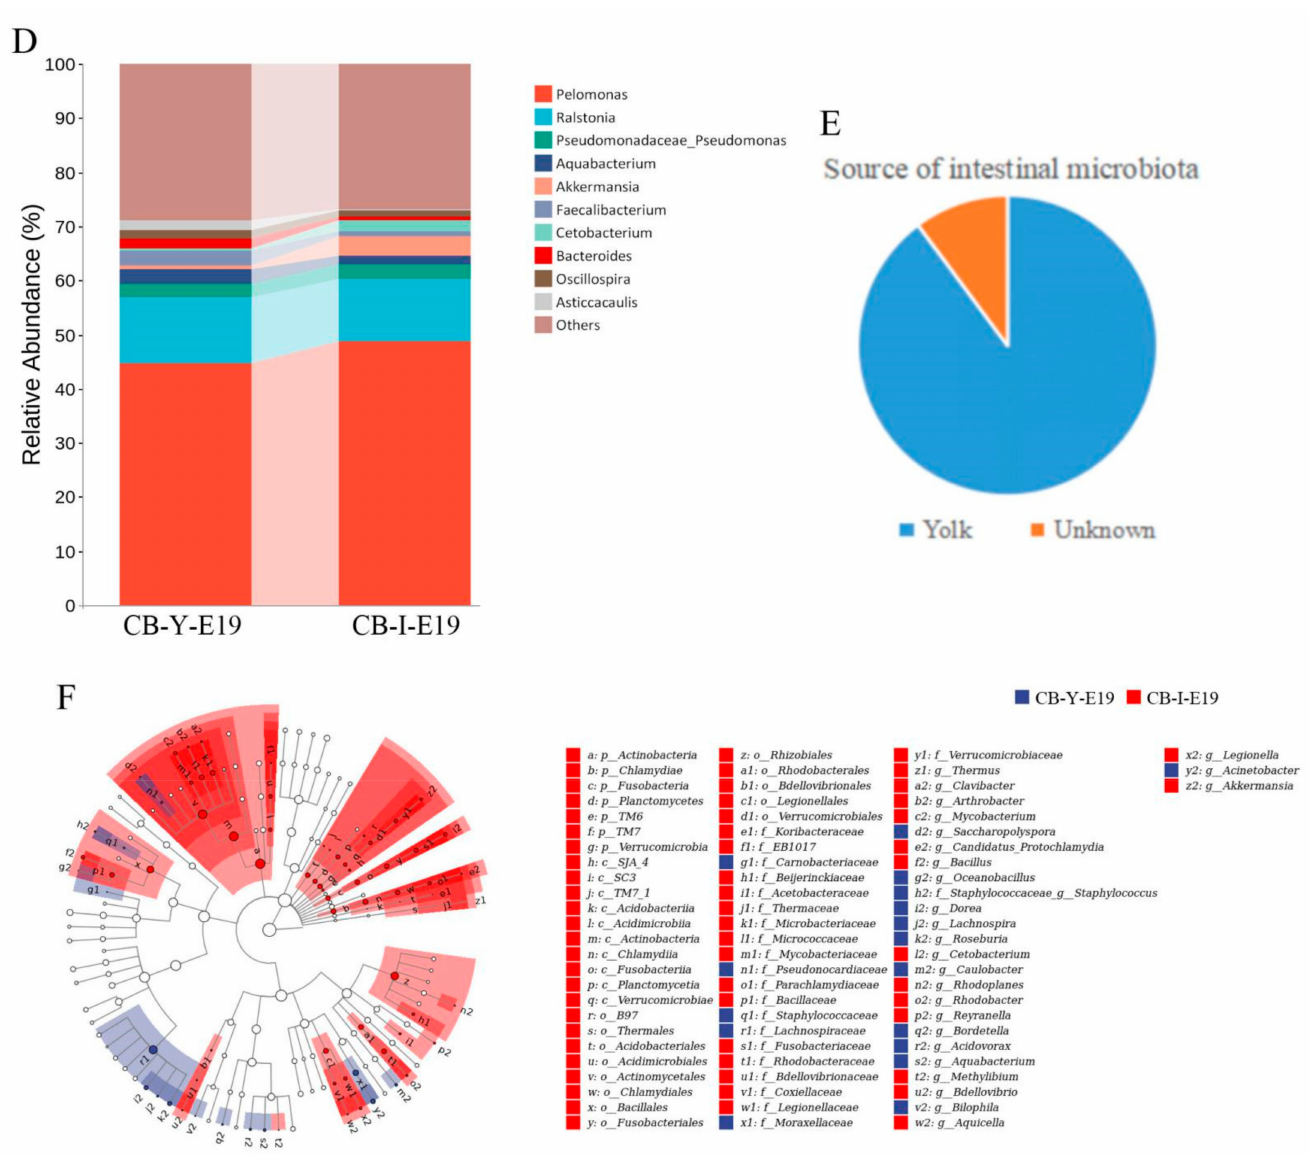
Figure 4. Comparison of embryonic microbiota between yolk and intestine and Source Tracker proportion estimates for a subset of sink samples. ( A ) PCA: Each point represents a sample, and points of different colors indicate different groups. ( B ) Each panel corresponds to an alpha diversity index, which is identified in the gray area at the top. In each panel, the abscissa is the group label, and the ordinate is the value of the corresponding alpha diversity index. ( C ) The relative abundance of yolk microbiota and intestinal microbiota at E19 (at the phylum level). ( D ) The relative abundance of yolk microbiota and intestinal microbiota at E19 (at the genus level). ( E ) Intestinal microbiota source of chicken embryos, using bacterial source-tracking. ( F ) Taxonomic cladogram generated from LEfSe showing significant difference in the microbiota profile of yolk microbiota and intestinal microbiota at E19. CB in the picture represents commercial broilers, Y represents yolk, and I represents